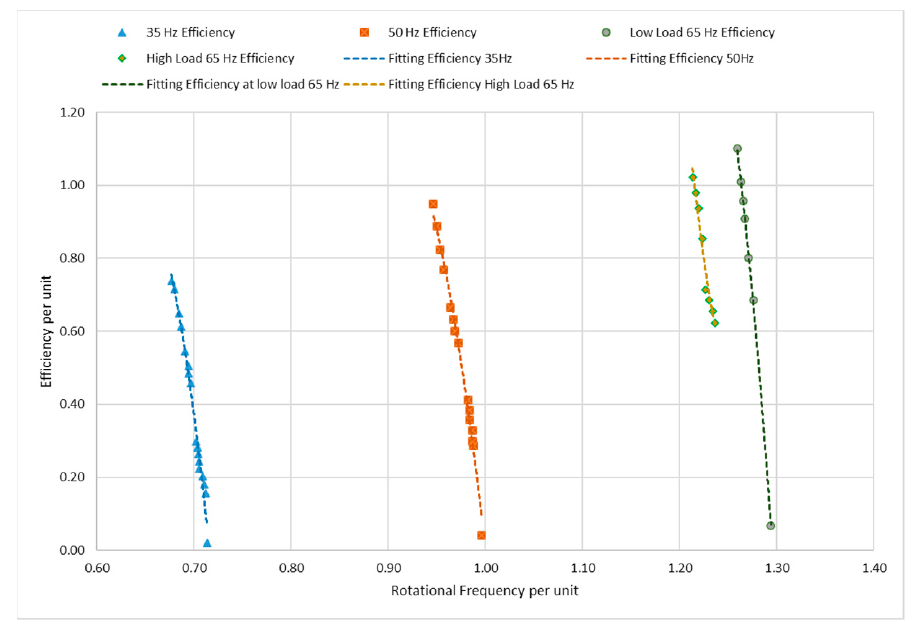
Figure 14. E ffi ciency of controlled system at 35 Hz, 50 Hz and 65 Hz (in per unit).